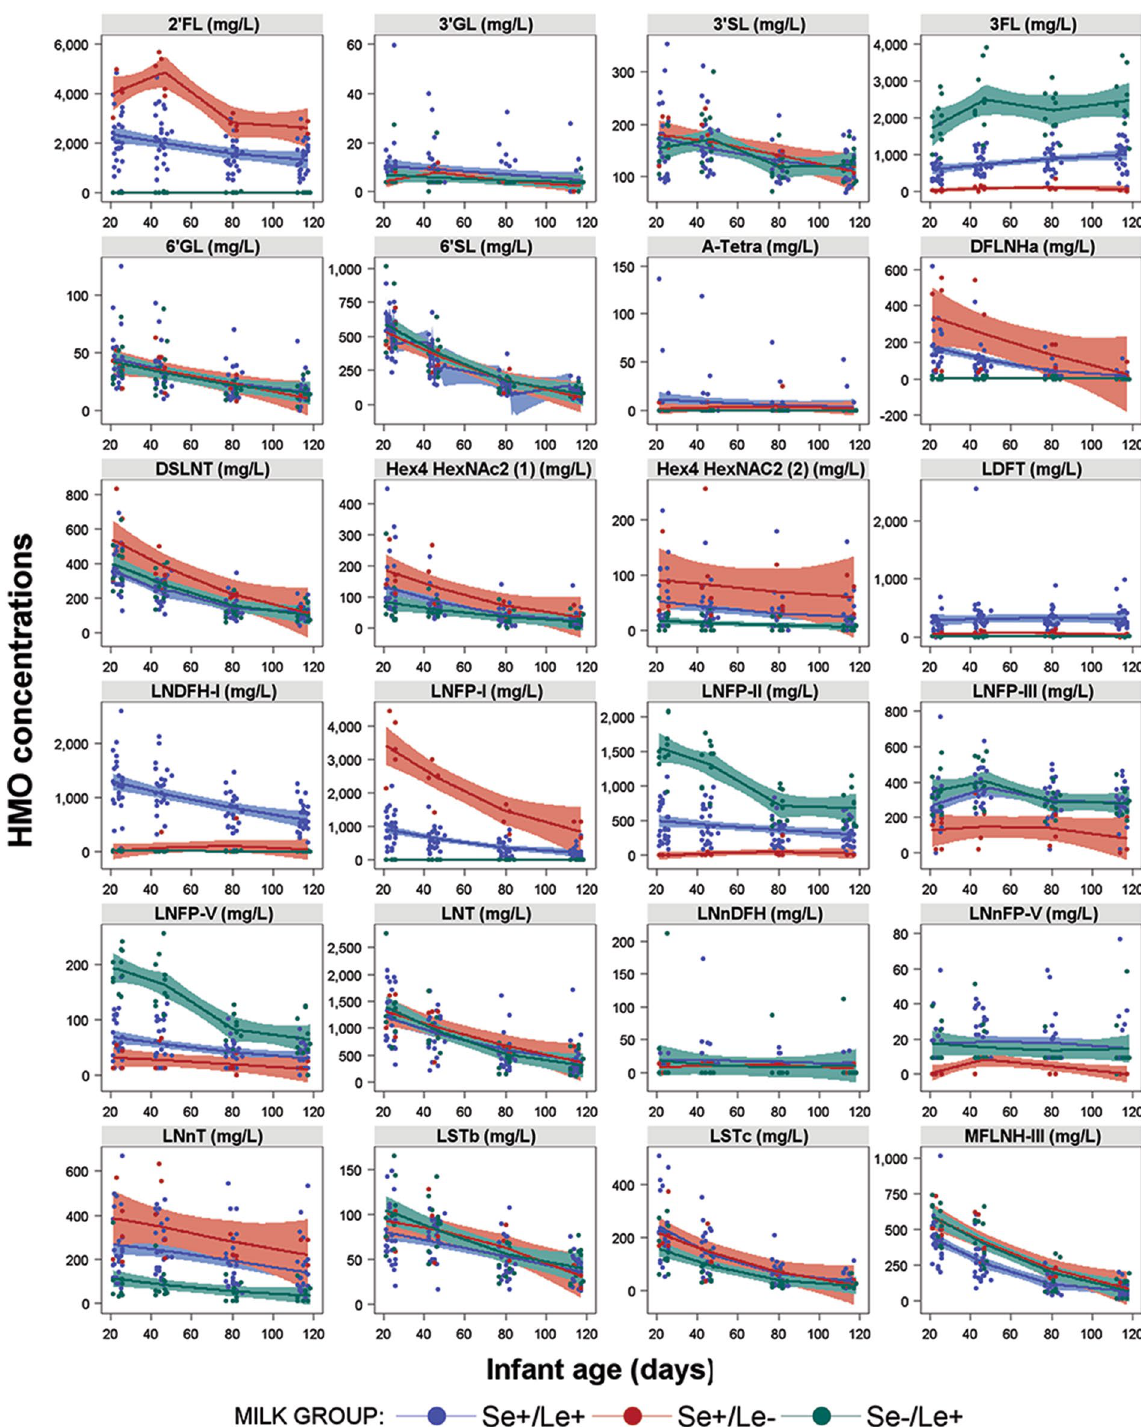
Figure 2. Trajectories of HMO concentrations over the first 4 months of lactation by milk group with n = 25 for Se+/Le+, n = 5 for Se+/Le−, n = 10 for Se−/Le+ . Not shown is n = 1 for Se−/Le−. Full names of all HMOs are provided in the methods